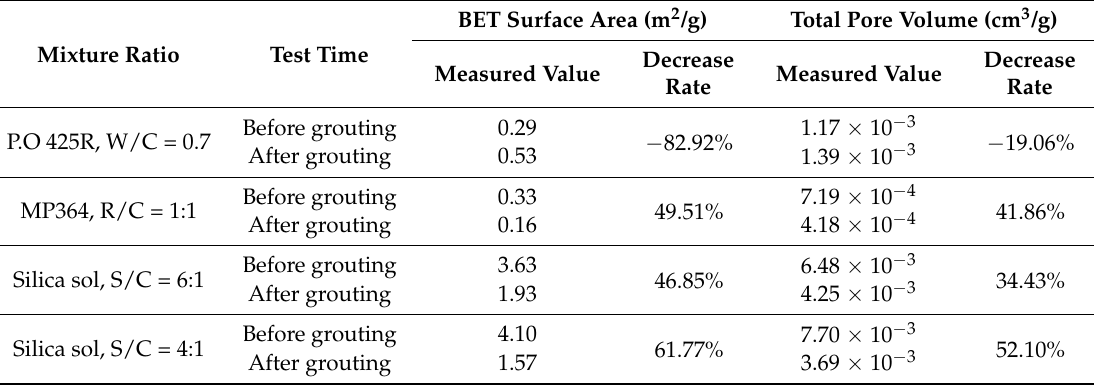
Table 3. BET surface area and total pore volume for four samples before and after grout impregnation. BET Surface Area (m 2 /g) Total Pore Volume (cm 3 /g) Mixture Ratio Test Time Measured